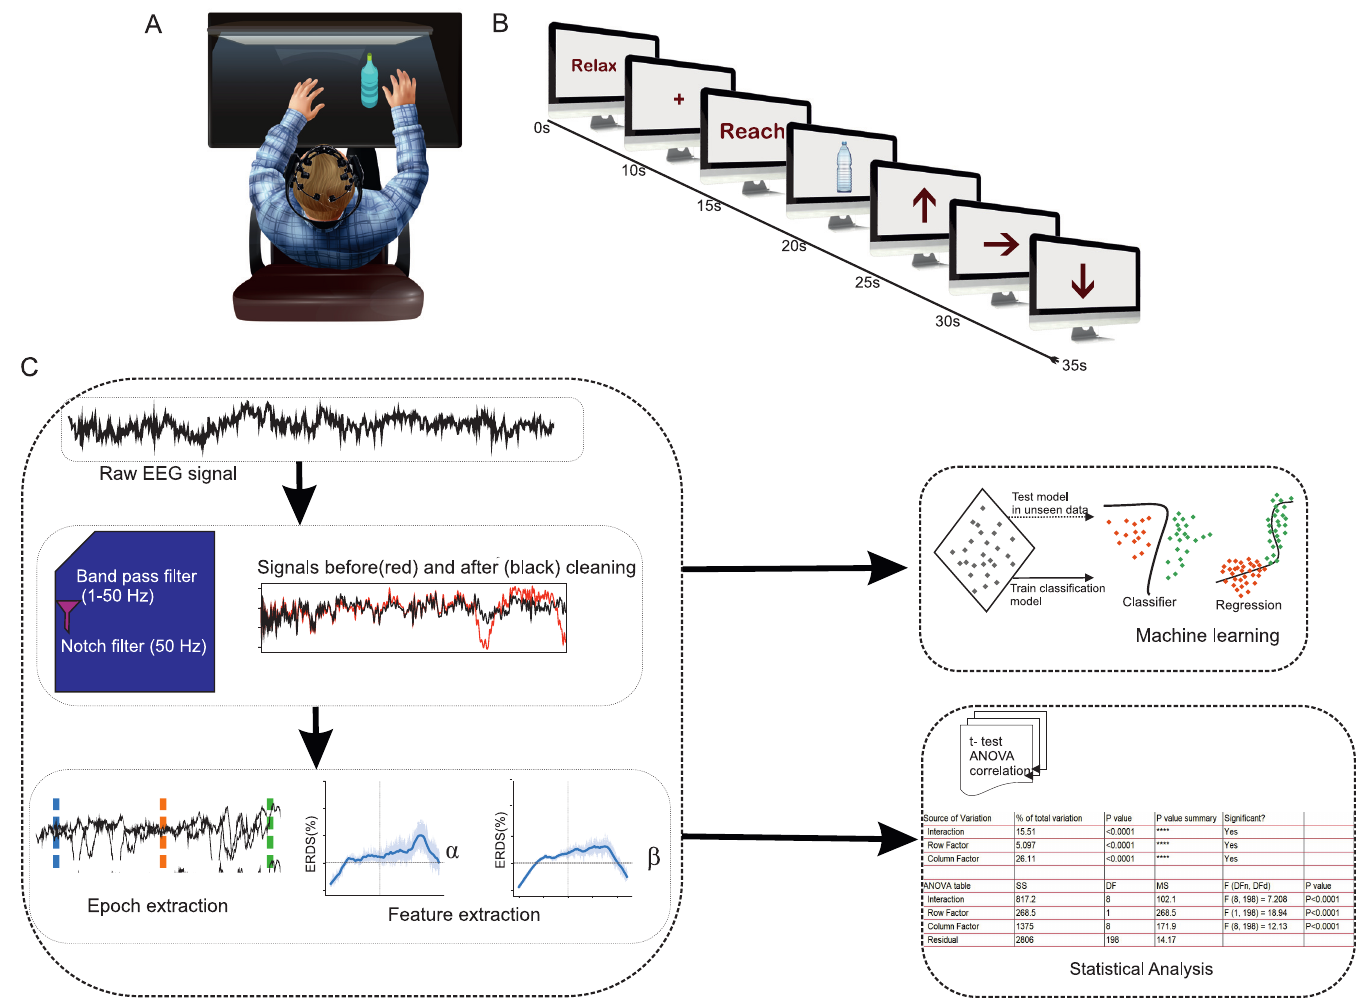
Fig 1. Schematic representation of experimental protocol and configuration. (A) Sitting posture of the subject during the neurophysiological recording (B) The timeline points to the temporal reference for various tasks initiated with a ‘relax’ state that started at 0s, “+” visual cue at 10s for the subject to be ‘alert’, at 15s ‘ Reach’ cue indicated the subject to reach for the object placed in the front of the subject, and at 20s ‘Object’ cue appeared to indicate the subject to grasp the object, followed by “arrow” cue at 25s to lift the bottle, consequently followed by another ‘arrow’ cue at 30s that suggested the direction in which the object was to be moved and a ‘down arrow’ cue at 35s that suggested to place the grasped object back at rest. (C) EEG Data processing analysis workflow involved the filtering of raw signal, epoch extraction, feature extraction and building a machine learning model based on processed features.